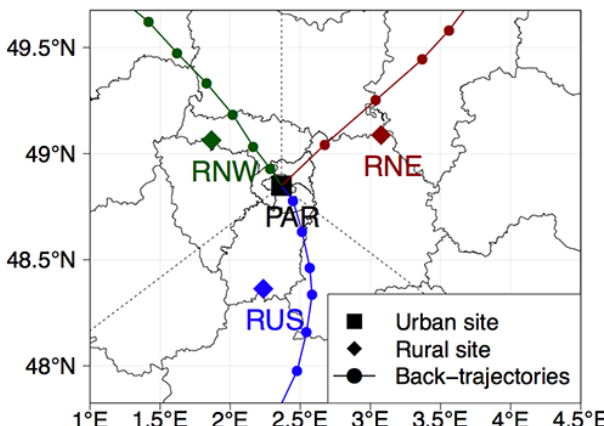
Figure 2. Location of measurement sites in Paris (urban site, PAR) and around (rural sites, RNE, RUS, RNW) greater Paris. Straight black lines delimit the three wind sectors. Back-trajectories for 3 specific days, one for each sector, are also represented by colored lines. Colored points over back trajectories indicate air mass loca- tion at each